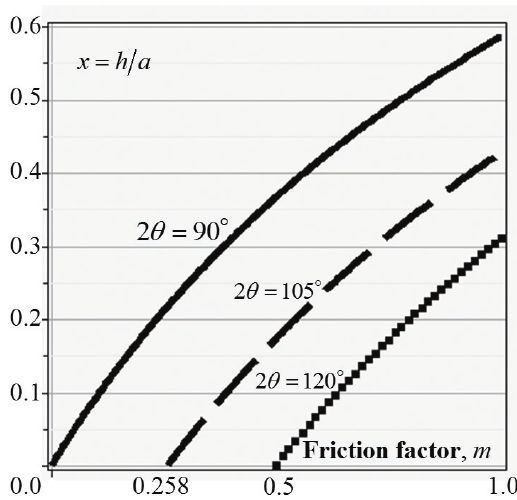
Figure 5. The character of the influence of friction factor m and the angle 2 θ between the channels of the Segal angular die on the formation and the relative height x=h/a of dead zone CDE during ECAE: ▬▬▬▬ ( 2 θ =90° ), ▬ ▬ ▬ ( 2 θ =105° ), and ■ ■ ■ ■ ( 2 θ =120° ). For die angle 2 θ =90° we have x≥0 for 0≤m≤1.0 ; for 2 θ =105° we have x≥0 for 0.258≤m≤1.0 ; and for 2 θ =120° we have x≥0 for 0.5≤m≤1.0 .